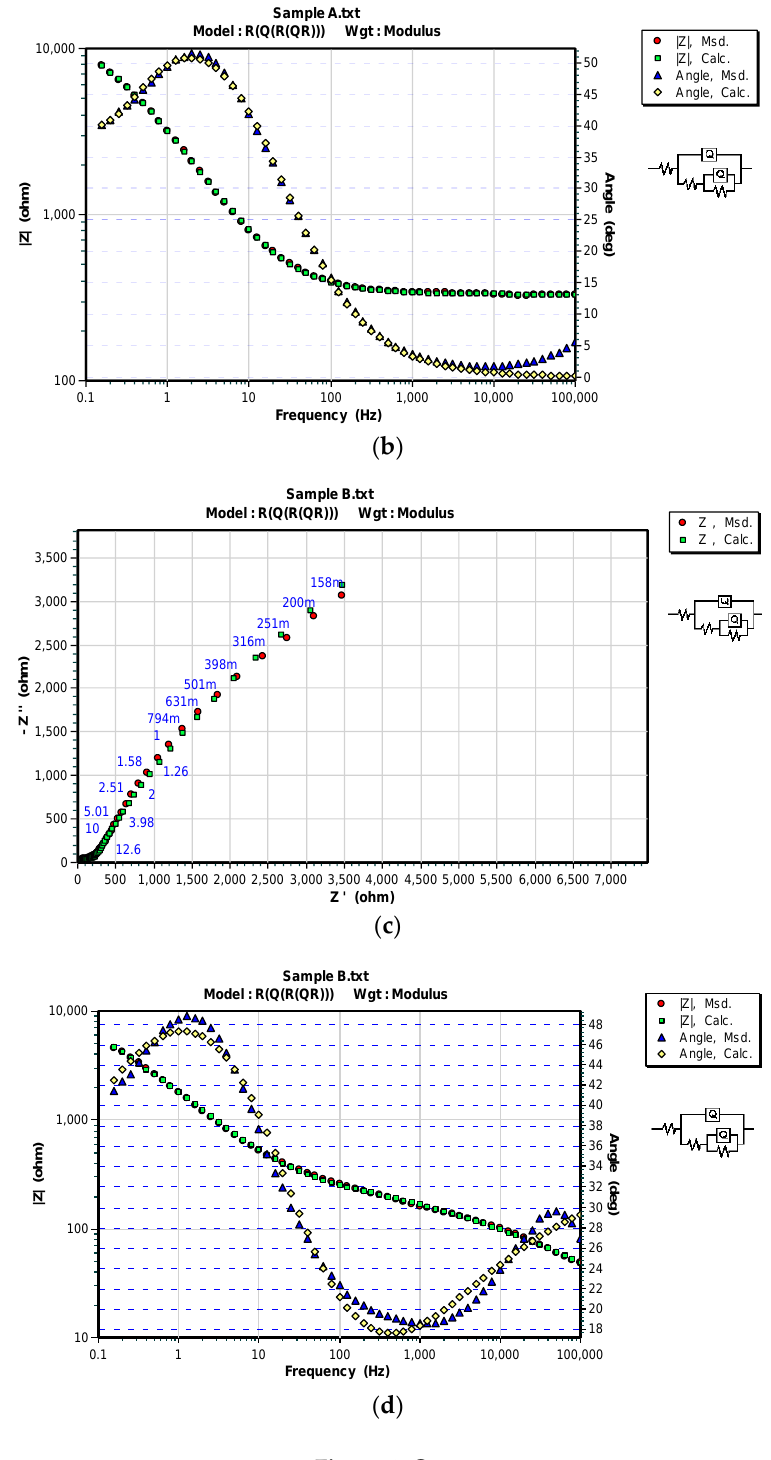
Figure 4. Cont. Figure 4.